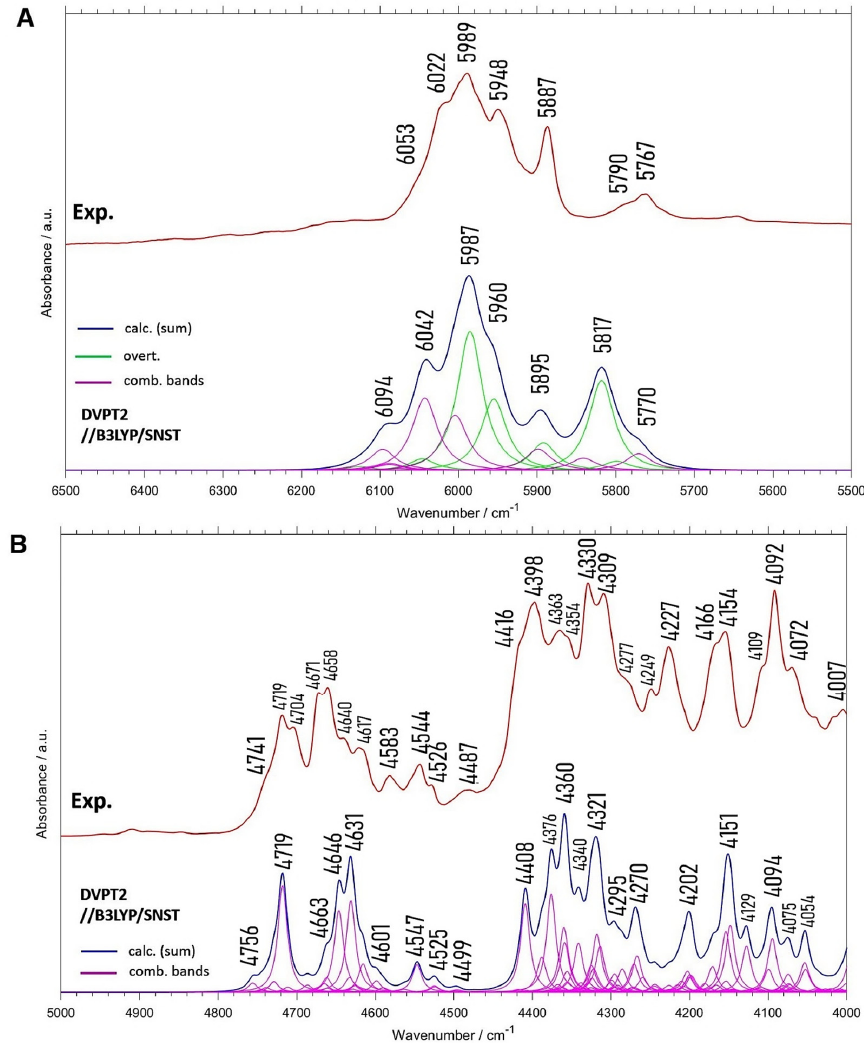
Figure 4. Experimental and calculated NIR spectra of Vitamin K 3 in 6500–5000 cm − 1 ( A ) and 5000–4500 cm − 1 ( B ) region.